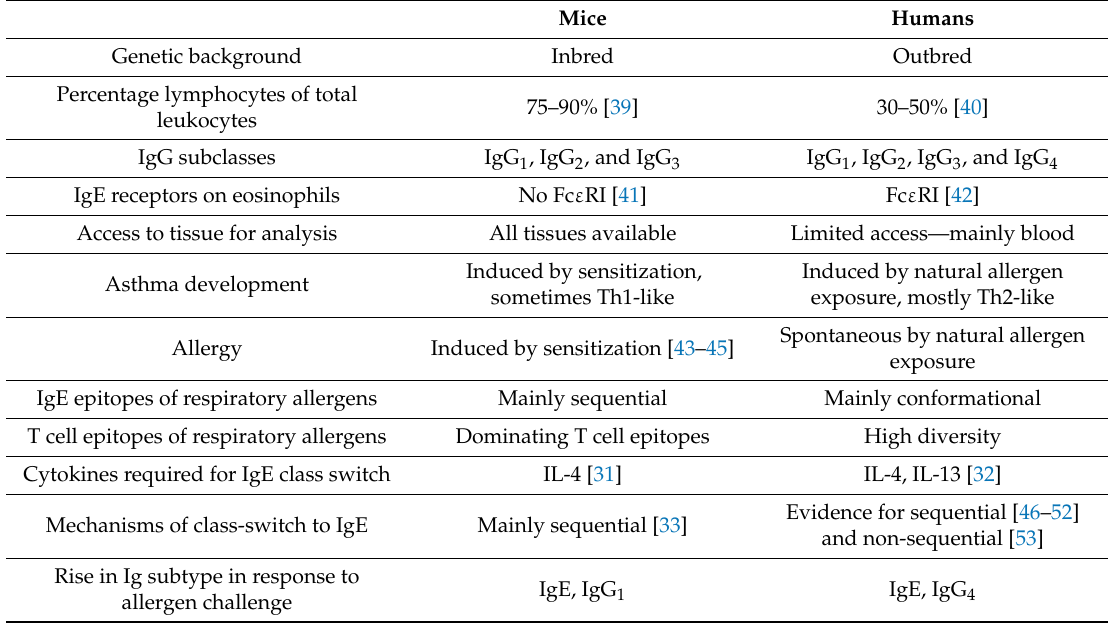
Table 1. Comparison of allergy in humans and murine